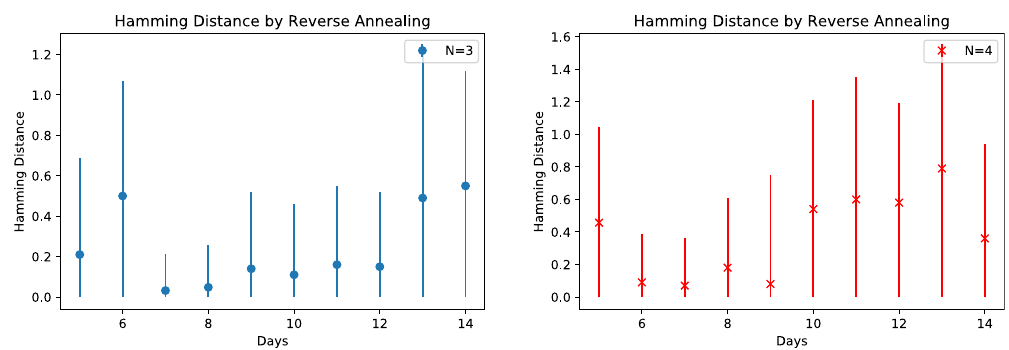
Figure 8. The Hamming distance of consecutive reverse annealing solutions (1000 samples for each problem). Error bars are based on the standard